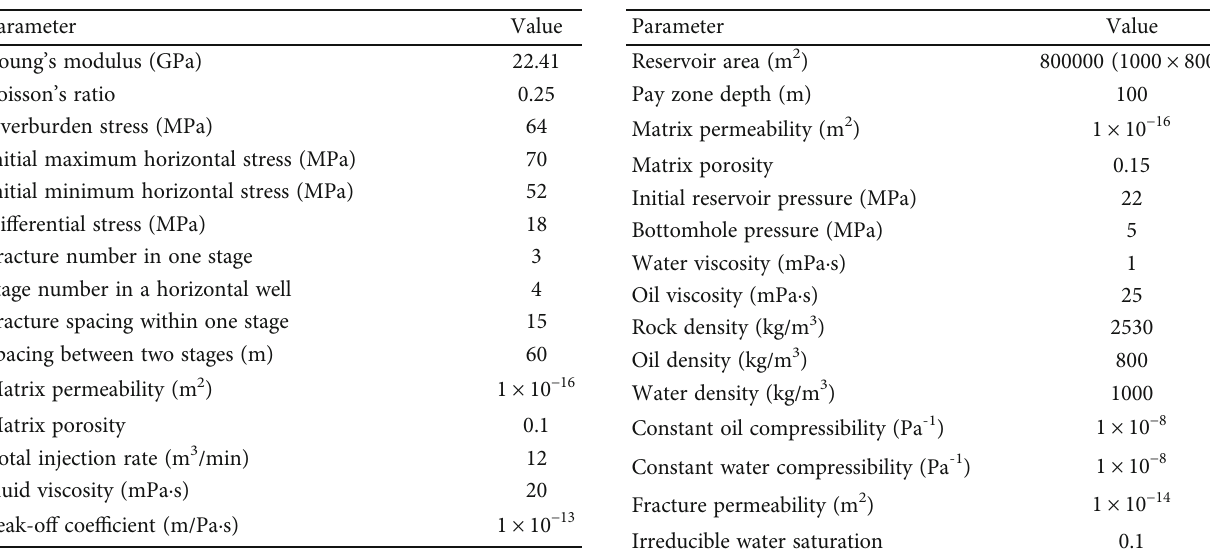
Table 2: Parameters for the base case of reservoir simulation